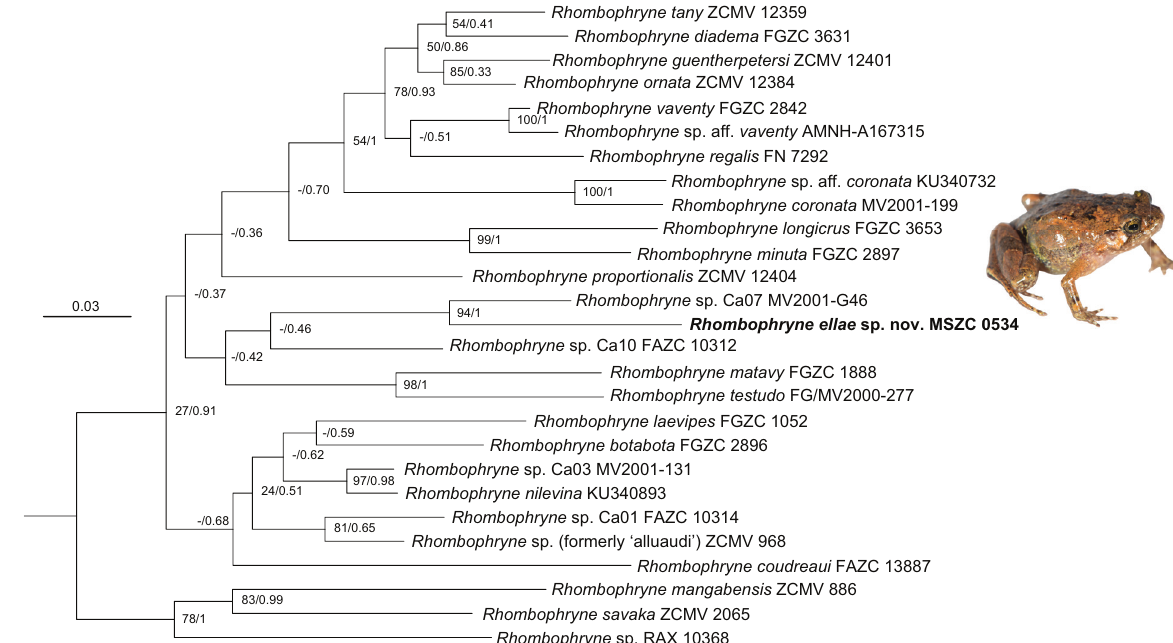
Figure 1. Bayesian inference phylogeny of Rhombophryne based on concatenated sequences of the mitochondrial markers 16S rRNA and COI (1134 bp). Values at nodes indicate percent bootstrap support (BS)/Bayesian posterior probability (PP); ‘-’ indicates clades not recovered in the ML tree. Anodonthyla montana was used as outgroup (not shown for graphical reasons). Rhombophryne serratopalpebrosa is the only described species missing from this phylogeny, as no sequences of that species are